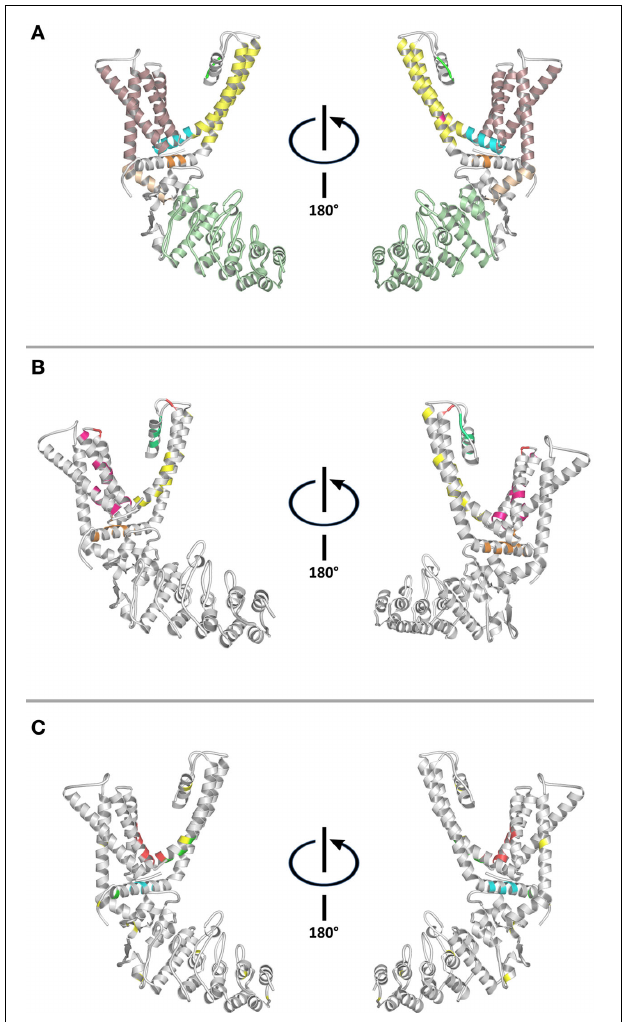
FIGURE 1 | Structural features of the capsaicin receptor. (A) Conserved structural domains: Ankyrin repeat domain—Olive. Pre-TM1 helix—Salmon. TM1-TM4 domain—Pale pink. TM4-TM5 linker—Cyan. Selectivity filter—Green. Gate—Fuchsia. TM5-TM6 domain—Yellow. TRP domain—Orange. (B) Residues involved in ligand-binding and/or modulation of channel activity: Colors represent residues location. TM1-TM4 domain—Fuchsia. Selectivity filter and pore helix—Green. TM5-TM6 domain—Yellow. Intracellular loops—Orange. Extracellular